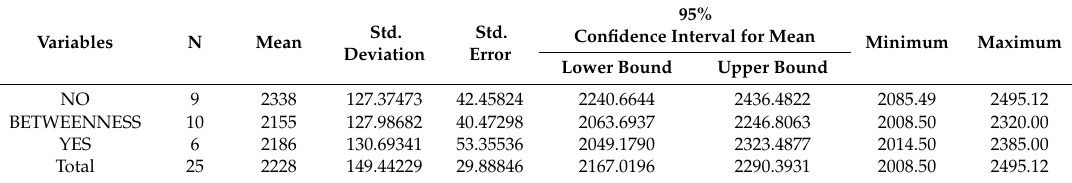
Table 8. Oneway descriptive statistics (Y22).